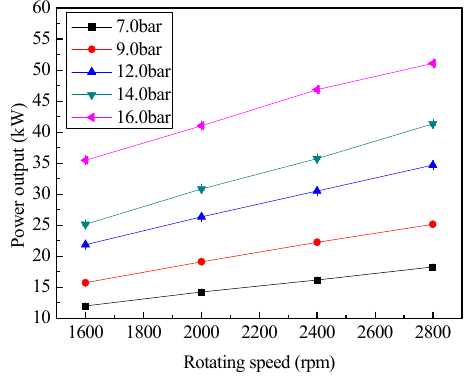
Figure 6. Power output versus rotating speed.